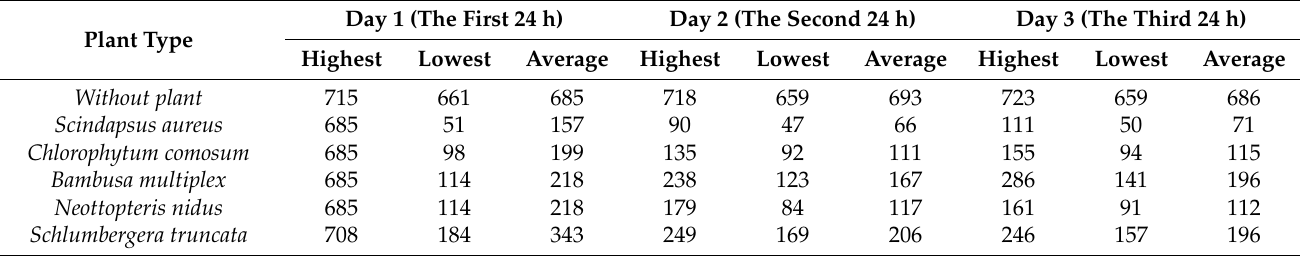
Table 4. Comparison of CO 2 concentration in sealed chambers in the poor lighting environment.